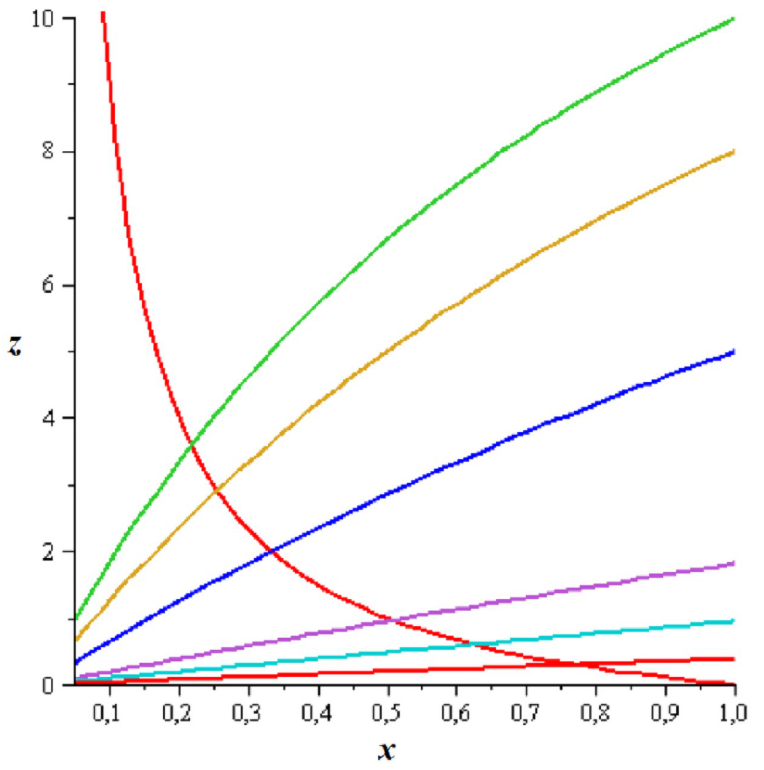
Fig 6. Location of the SS of System (12) in the phase space for parameter values b various values of L . Red hyperbola represents null-cline for x , while other curves represent null-clines for z for L = 0, 0.5, 2, 9, 19, 49 (from top to bottom).